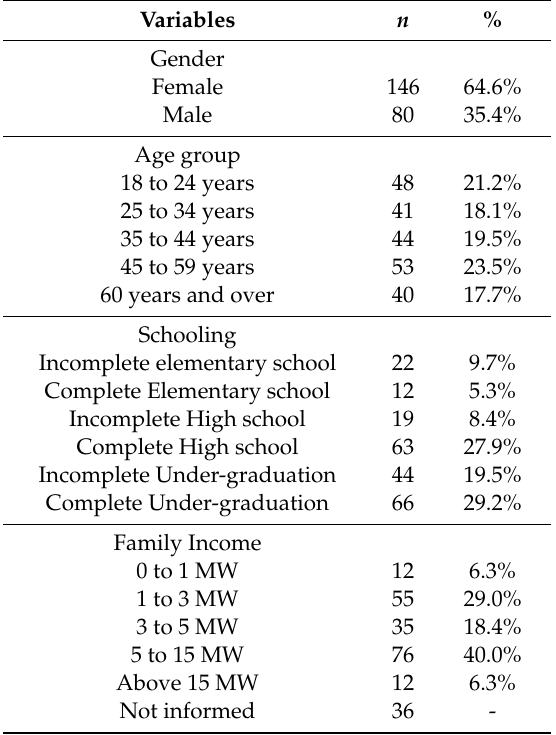
Table 1. Socio-demographic characterization of the home food handlers in the Federal District, Brazil,